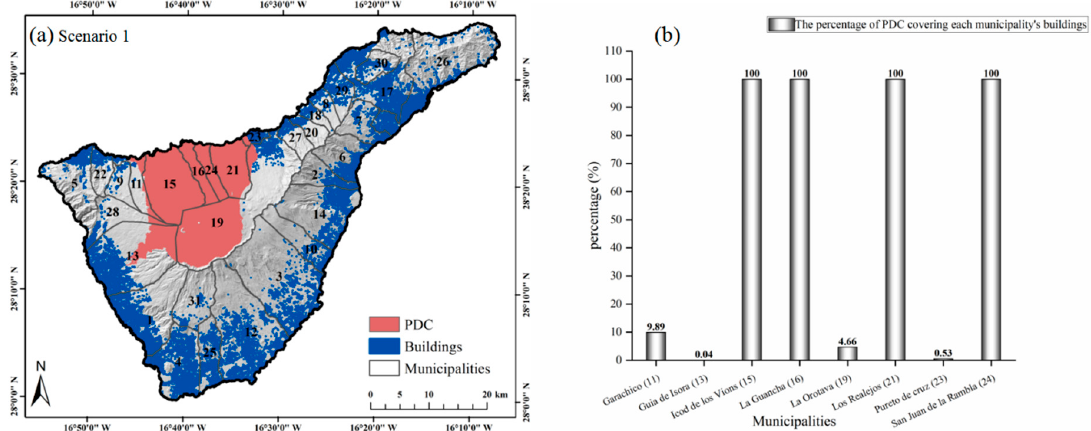
Figure 7. ( a ) The distribution of a simulated PDC in Scenario 1. ( b ) The percentage of buildings affected by PDC in municipalities.